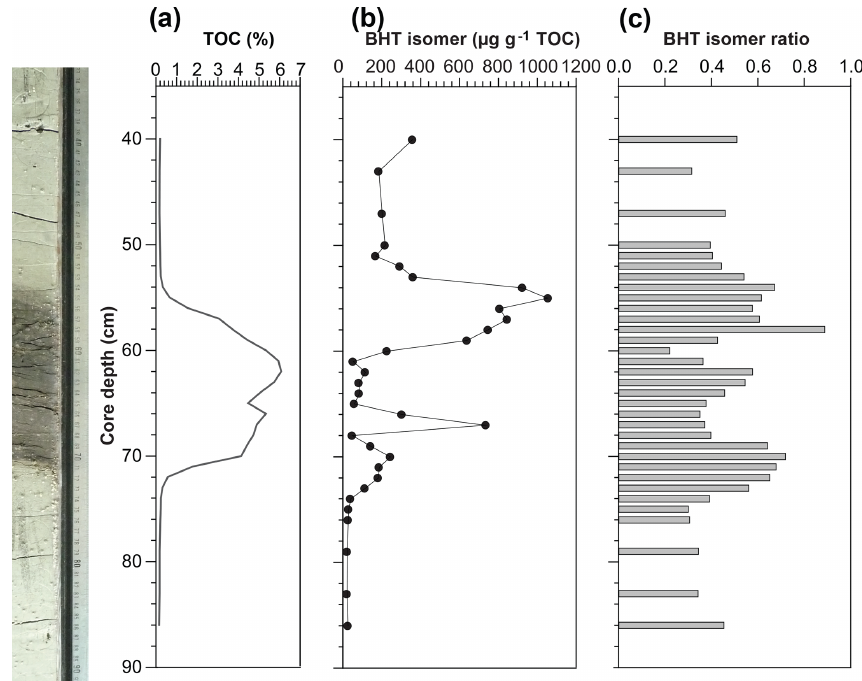
Figure 6. (a) Total organic carbon (TOC) content, (b) BHT isomer concentration, and (c) BHT isomer ratio through a Pliocene sapropel (2.67Ma) from the Levantine Basin (ODP Leg 160 Site 967). The sapropel is indicated by the darker sediment. Core photo provided by Luke